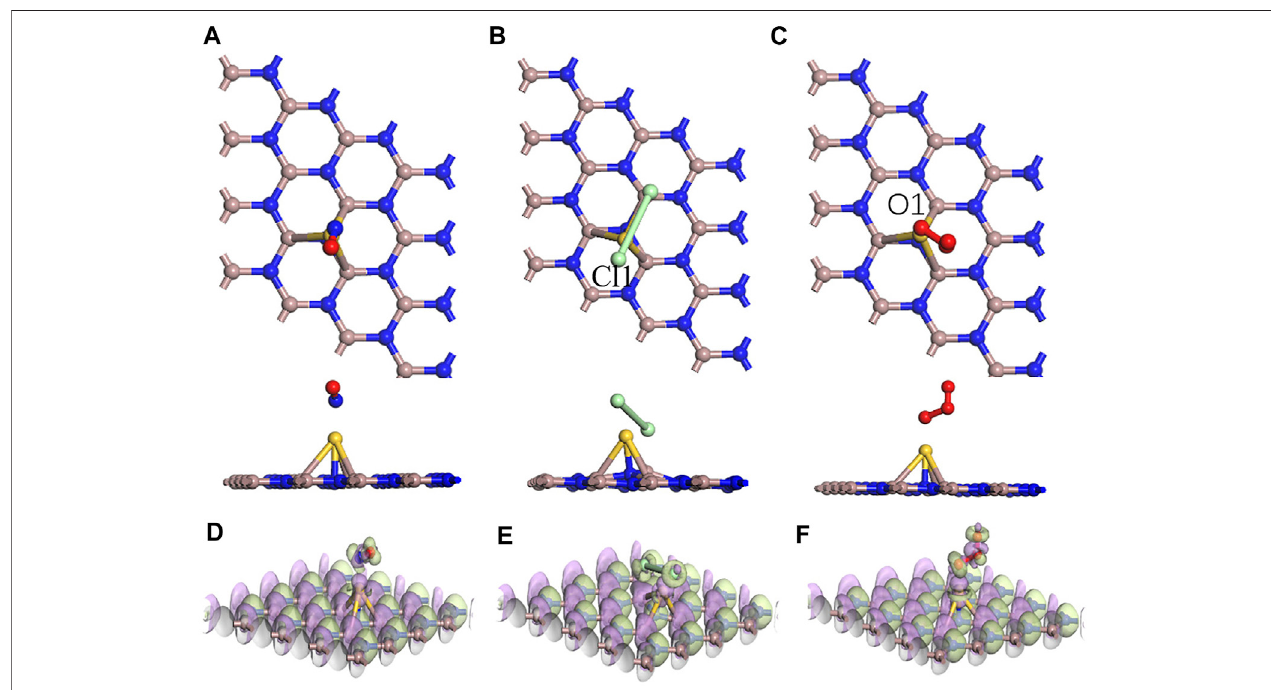
FIGURE 6 | Optimized structures for (A) NO, (B) Cl 2 , and (C) O 3 on the Au – GaN surface and EDD for (D) NO, (E) Cl 2 , and (F) O 3 on the Au – GaN surface (purple regions indicate loss of electrons, and green regions represent obtained electrons in EDD).